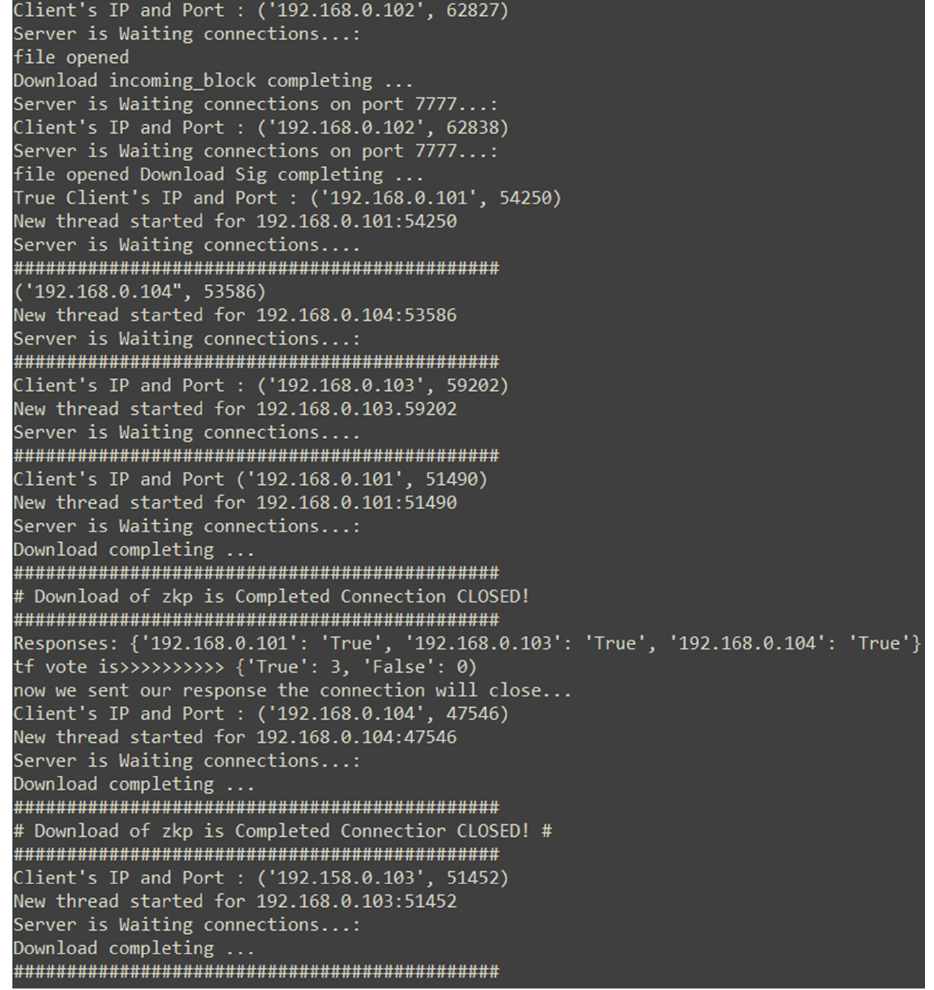
Figure 20. The regular node (192.168.0.100) receives the new block and the decision-making process.